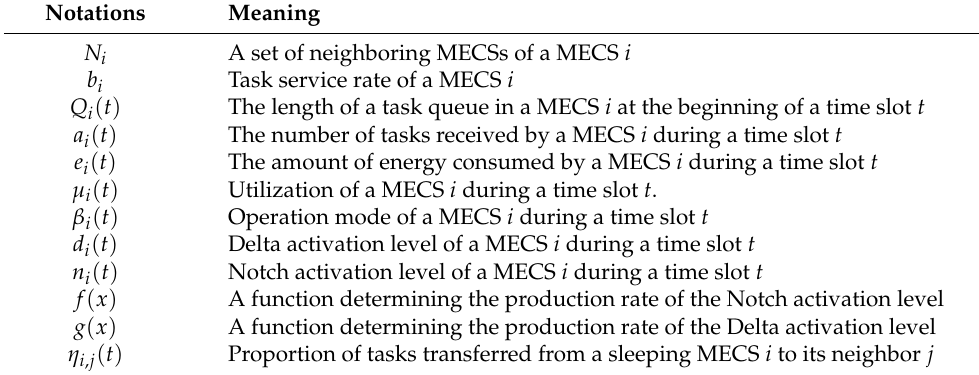
Table 1. Notations